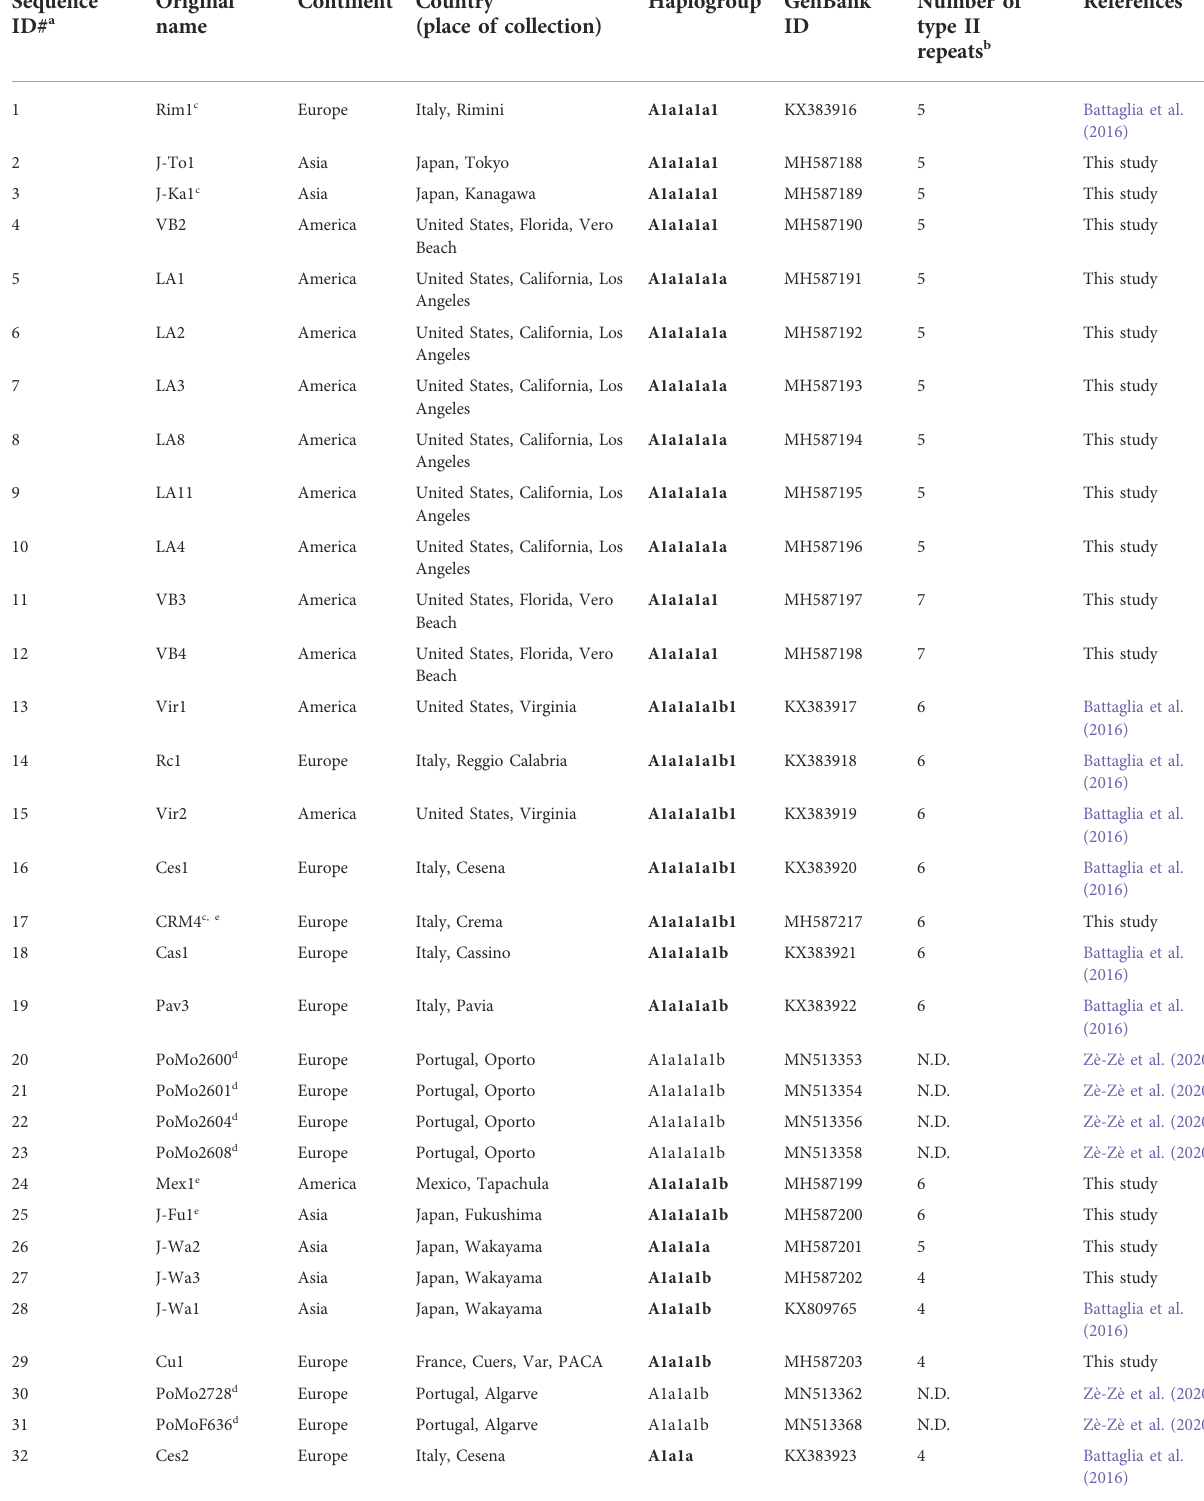
TABLE 1 Origin and haplogroup af fi liation of Ae. albopictus mitogenomes analysed in this study. The 37 newly sequenced samples are included together with 39 from previous studies. Haplogroups indicated in bold in the Table are new or re-de fi ned relative to (Battaglia et al.,